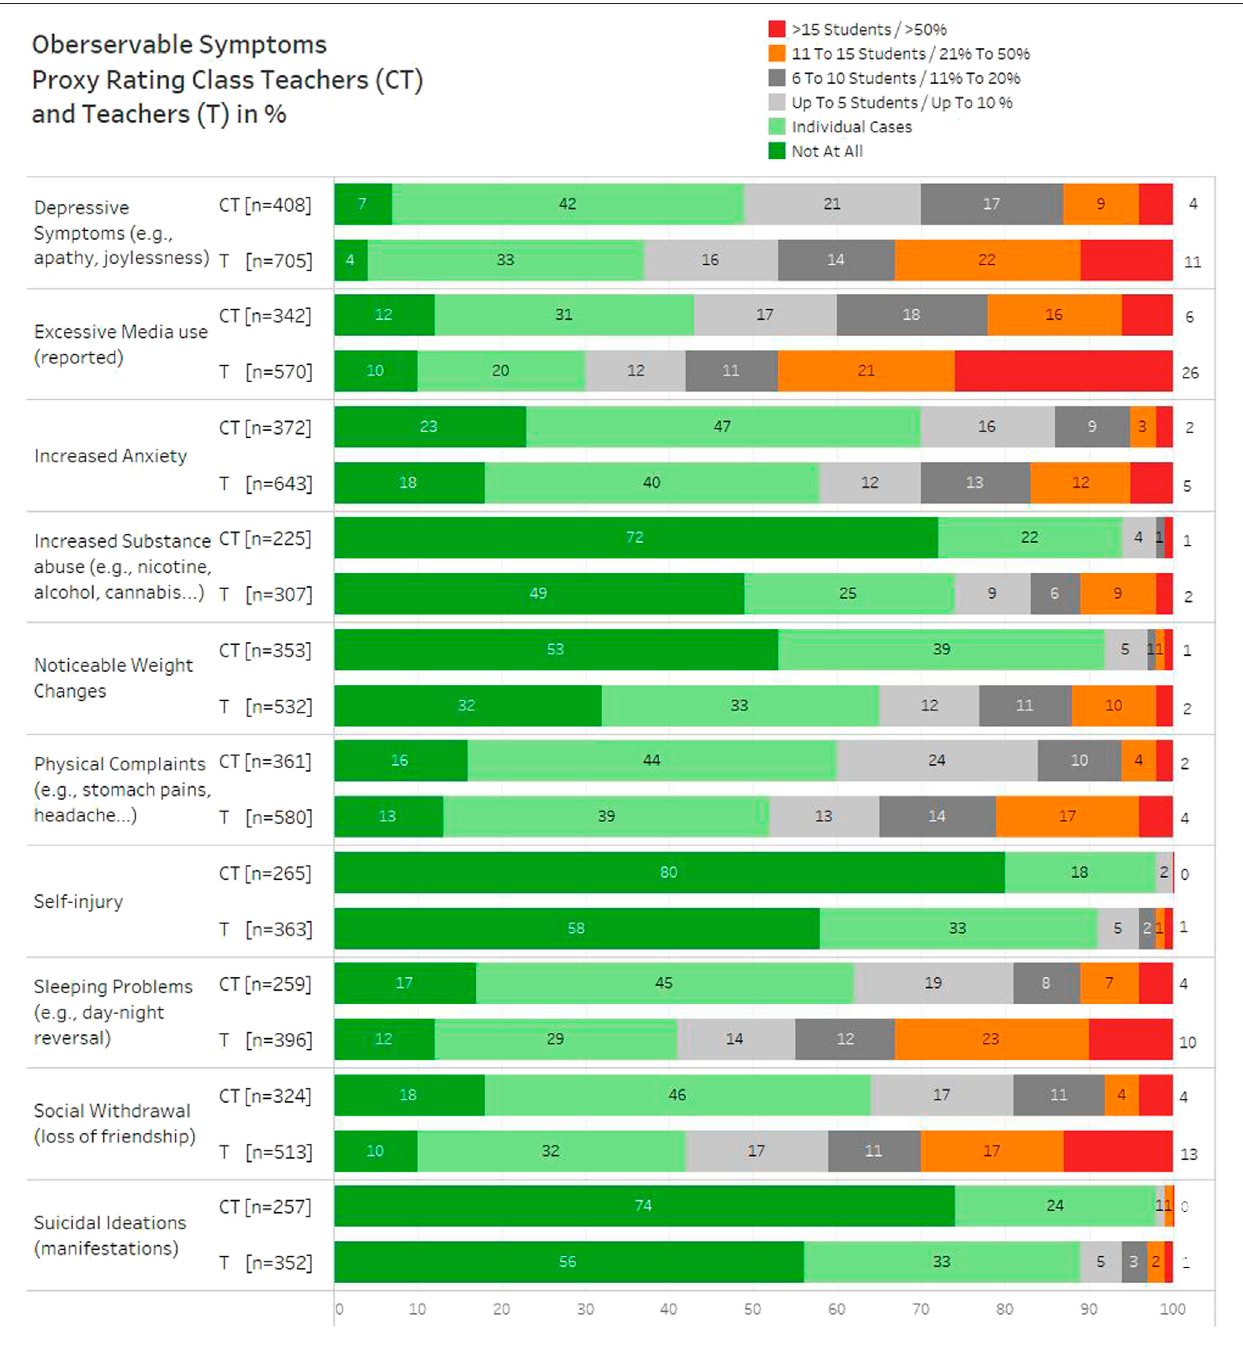
FIGURE 2 | Estimation of mental burdens/symptoms of students by